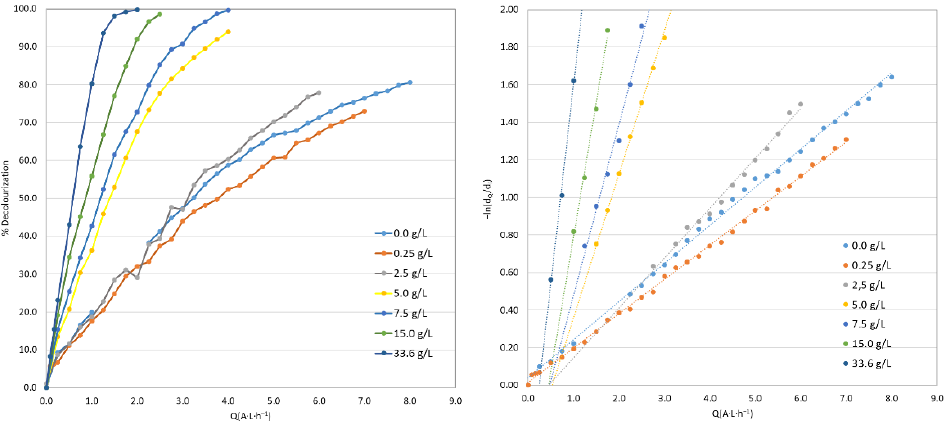
Figure 3. Influence of NaCl concentration of the kinetic results, working at a fixed conductivity.